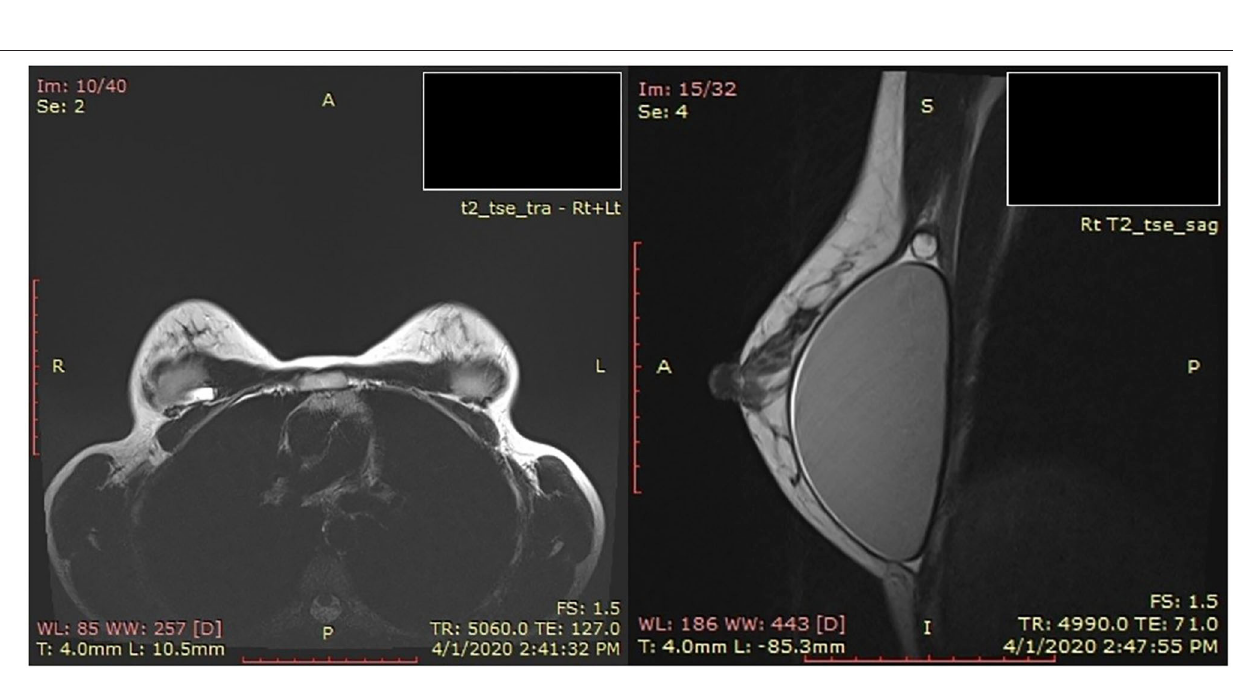
FIGURE 2 | Magnetic Resonance Imaging (MRI) of the breasts. Right breast – T2 sagittal: On the upper side of the silicone implant, a round foreign object, 1cm in